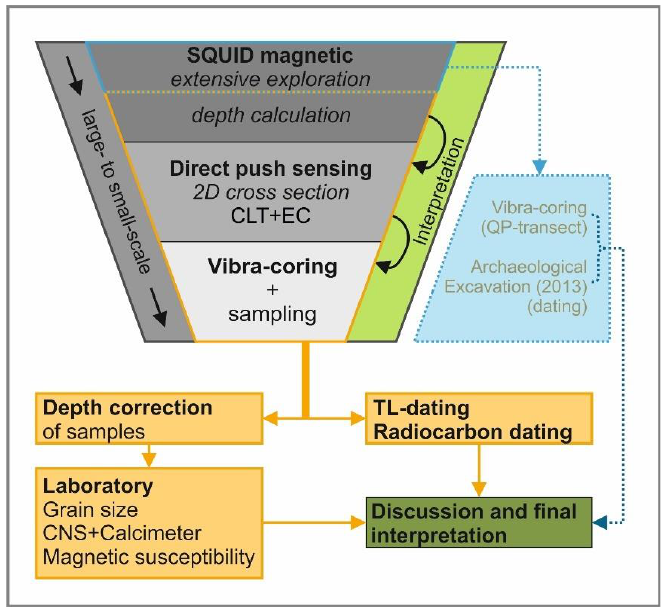
Figure 4. Multi-method approach used in geoarchaeological exploration at Fossa Carolina wetland site. We used data from previous investigations (in blue) and newly recorded data (in orange) for our interpretations (in green).